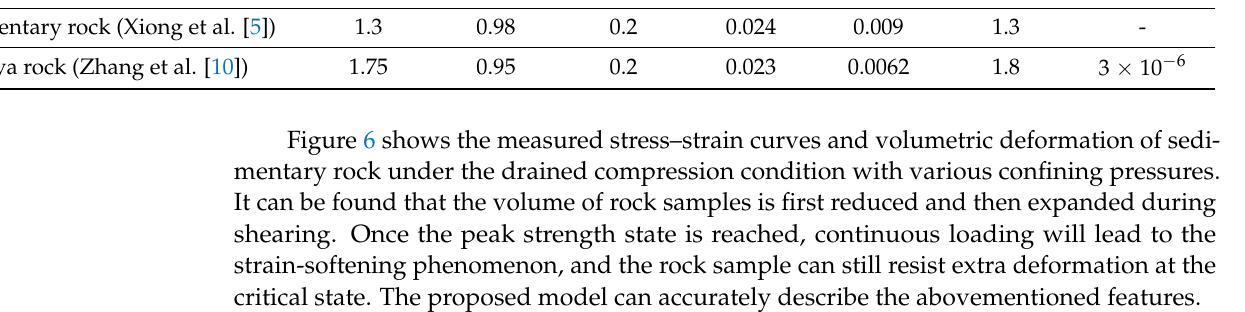
Table 1. Model parameters for Ohya rock (Xiong et al. [5] and Zhang et al. [10]). M e0 ν λ κ n α t Sedimentary rock (Xiong et al. [5]) 1.3 Ohya rock (Zhang et al. [10]) 1.75